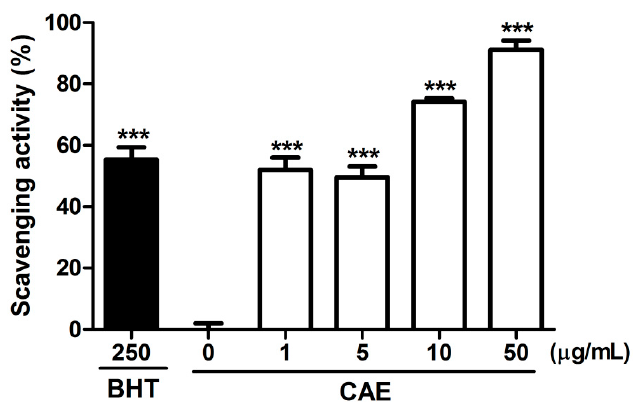
Figure 4. Superoxide anion scavenging activity (%) of CAE. BHT (250 μ g/mL) was used as the positive control. The superoxide anion scavenging activity of 1 and 5 μ g/mL CAE was similar to that of BHT. Significant difference versus control in each experiment: ***, p < 0.001.